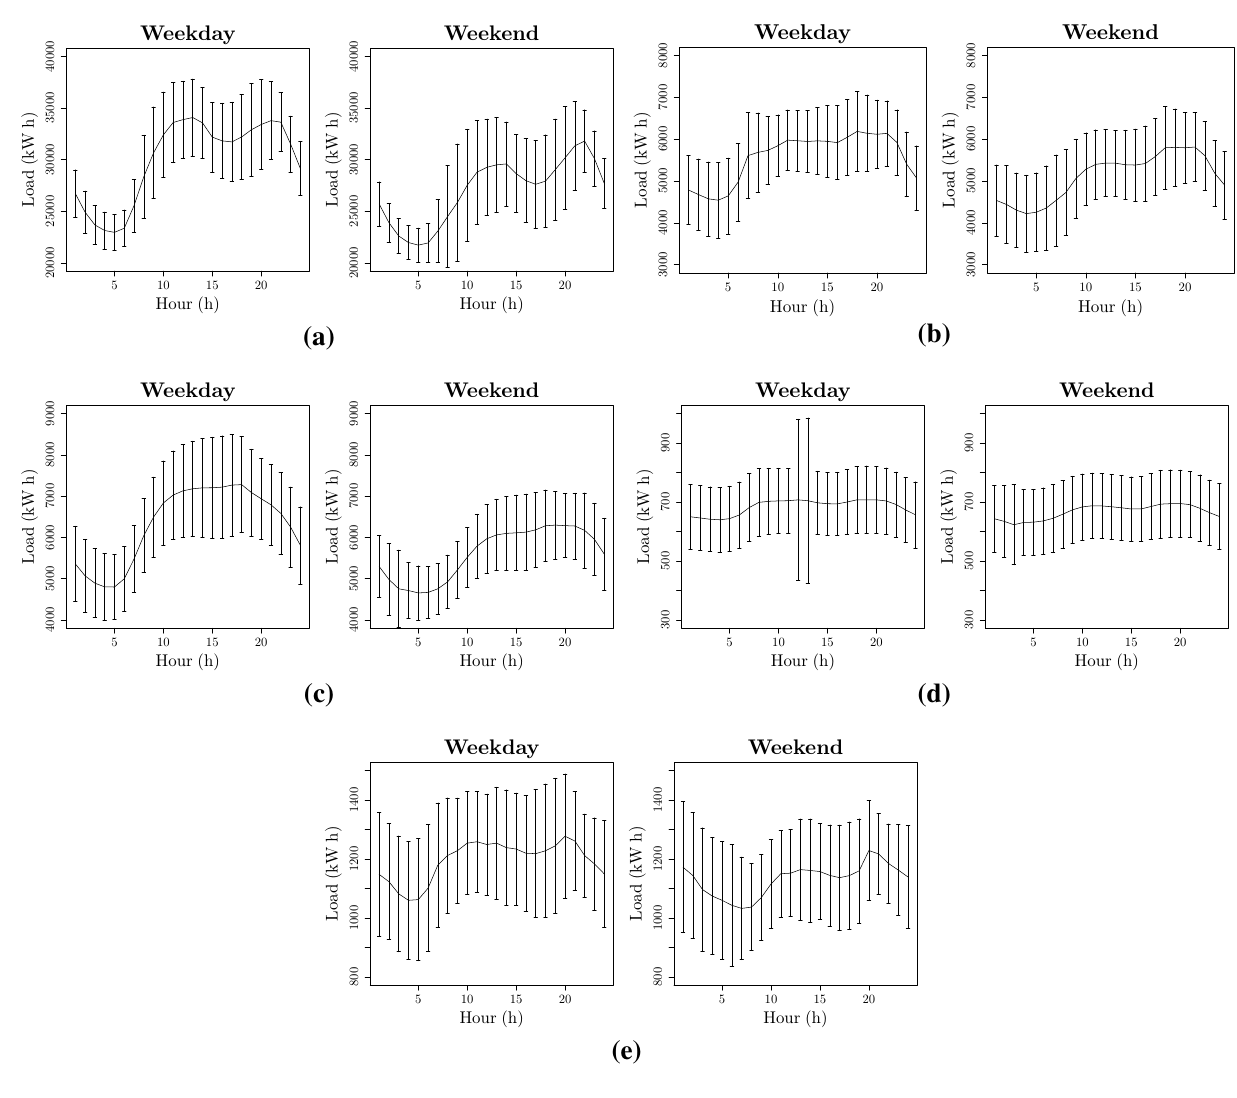
Figure 6. Average daily load ( kW h ). Error bars denotes ± σ . (a) Dataset REE ; (b)